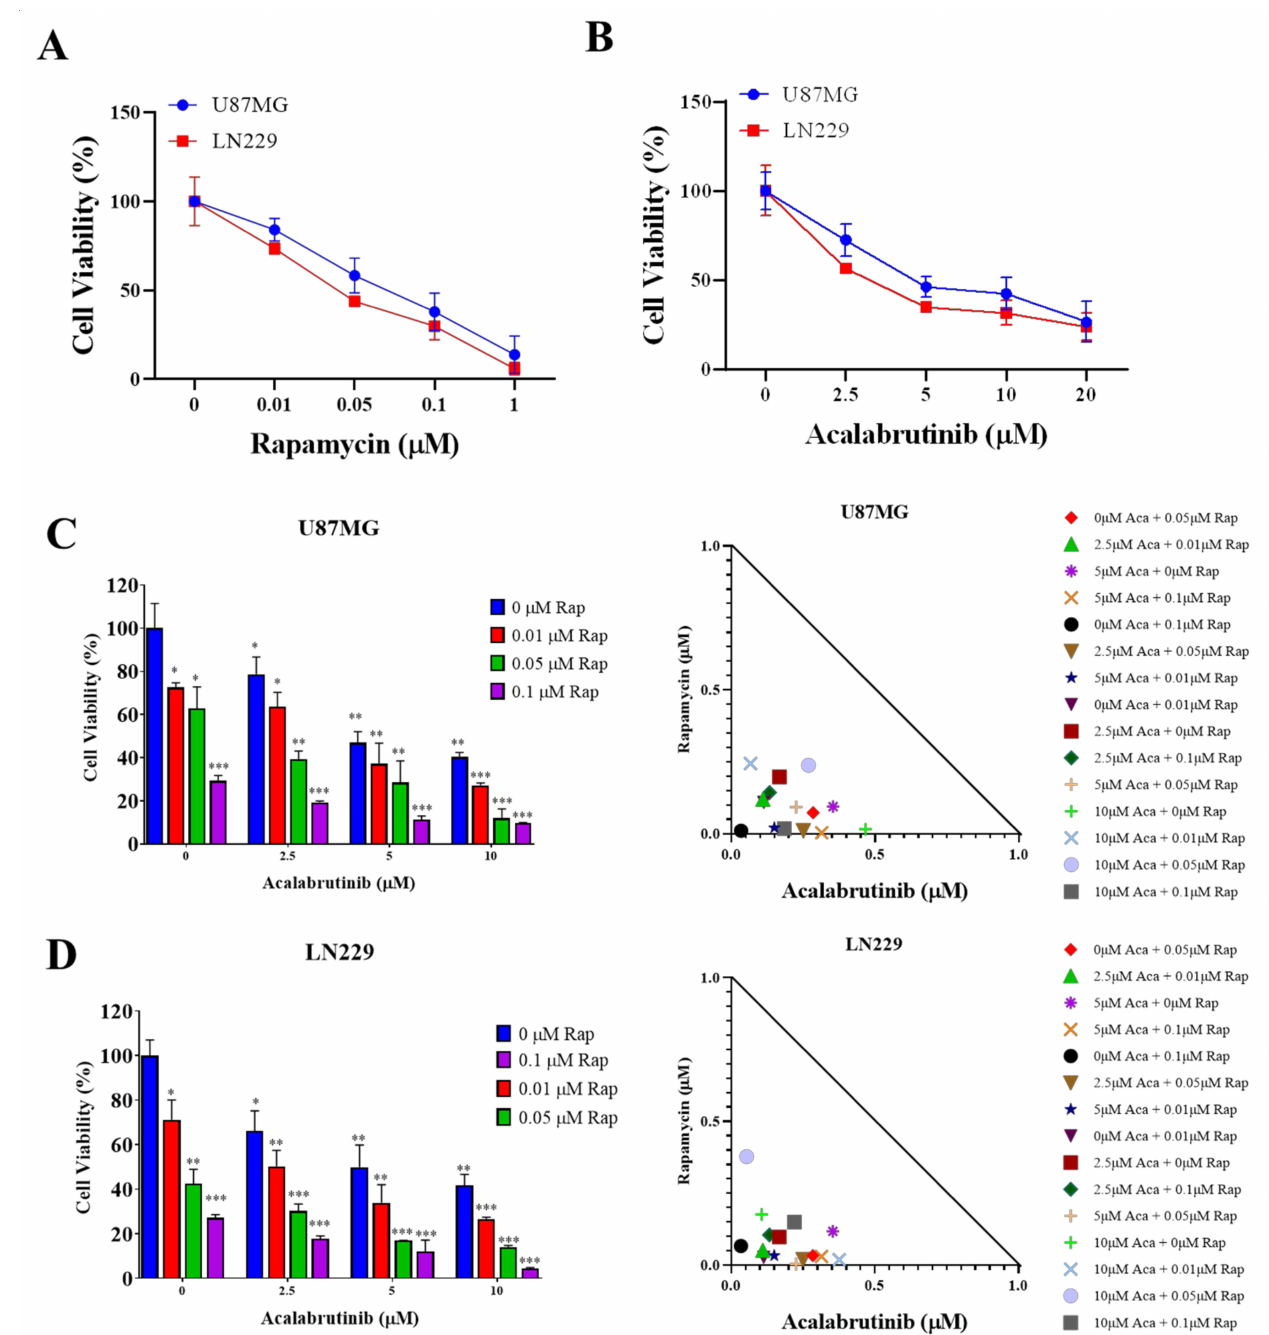
Figure 1. Combined acalabrutinib and rapamycin exhibits synergism. SRB assay for 48 h revealed the effectiveness of ( A ) rapamycin and ( B ) acalabrutinib in inhibiting the viability of GBM cell lines. Graphical representation and isobolograms of the effect and combination potential of 0.01–1 µ M rapamycin with 0–10 µ M acalabrutinib on the viability of ( C ) U87MG and ( D ) LN229, as quantified through 48-h SRB assay. Combination propensity and effect were evaluated using CompuSyn software based on the Chou–Talalay algorithm for drug combinations. Combinational effects are presented as the combina- tion index (CI), where CI < 1 indicates synergism (inner triangle), CI = 1 (on the hypotenuse) indicates an additive effect, and CI > 1 (outer triangle) indicates antagonism. * p < 0.05; ** p < 0.01; *** p <